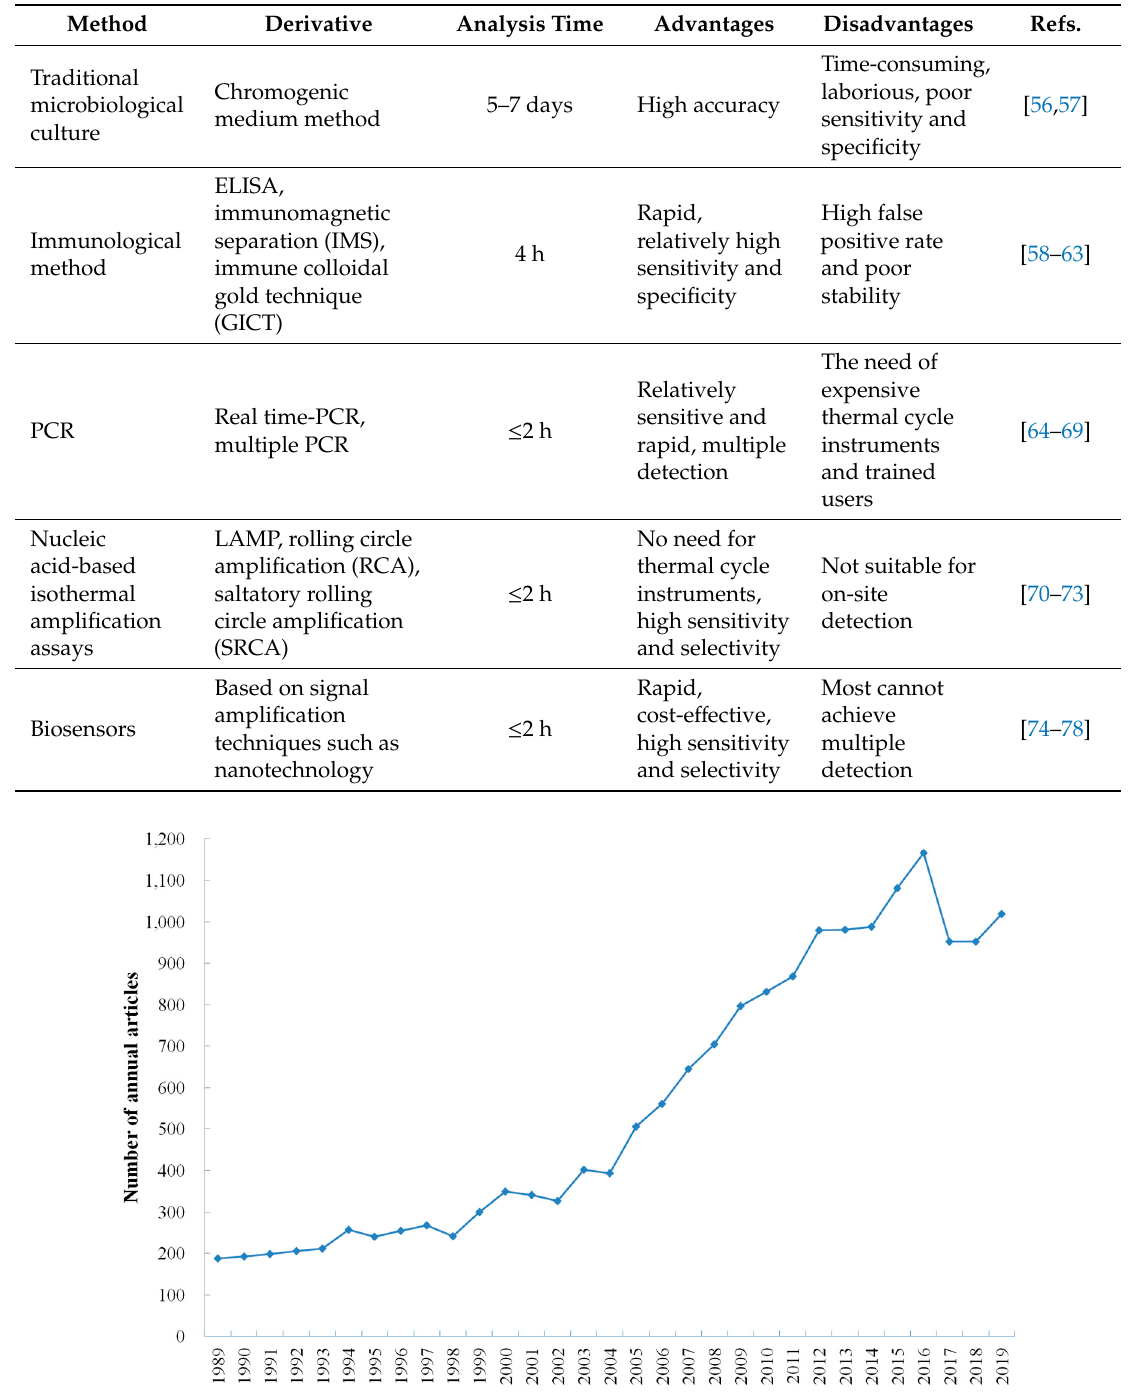
Figure 2. Number of publications for food borne pathogens detection with electrochemical DNA